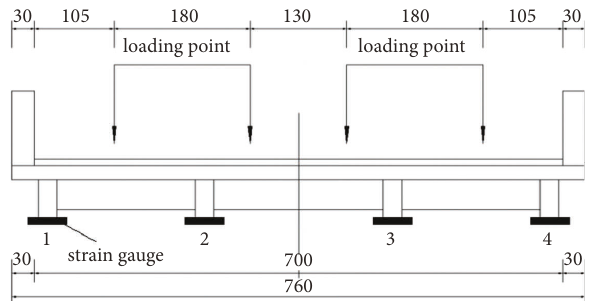
Figure 8: Loading